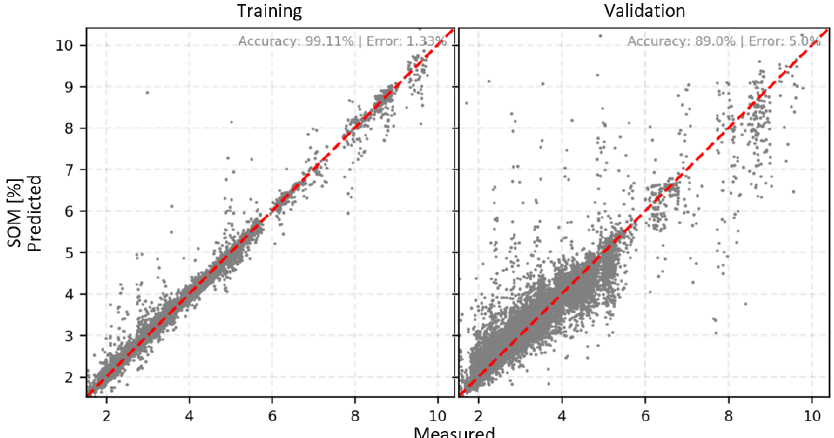
Figure 8. Predicted vs. measured (variance introduced pixel values) soil organic matter (SOM) content for the training and validation data. The red broken line represents the 1:1 line.